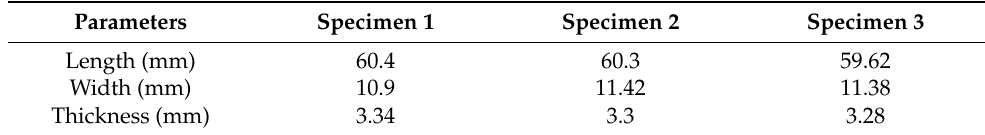
Table 1. Dimensions of specimens.